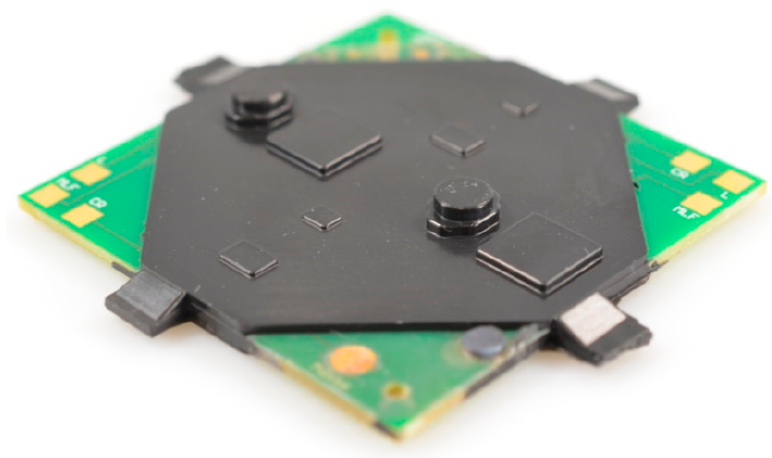
Figure 11. Encapsulated (1 mm thick) board-level package.